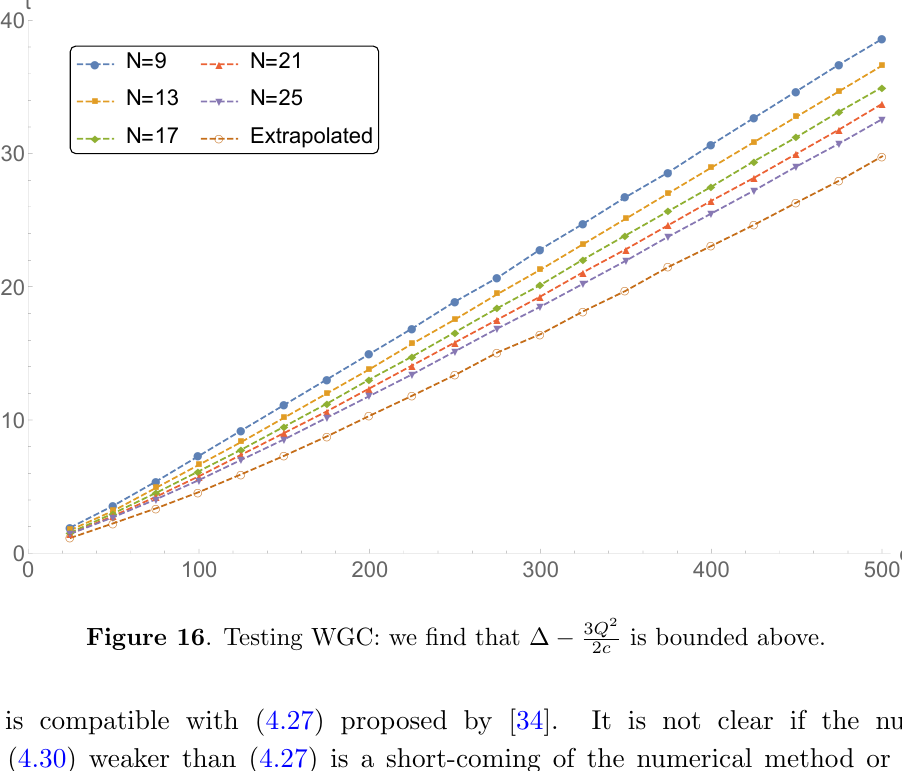
which is compatible with (4.27) proposed by